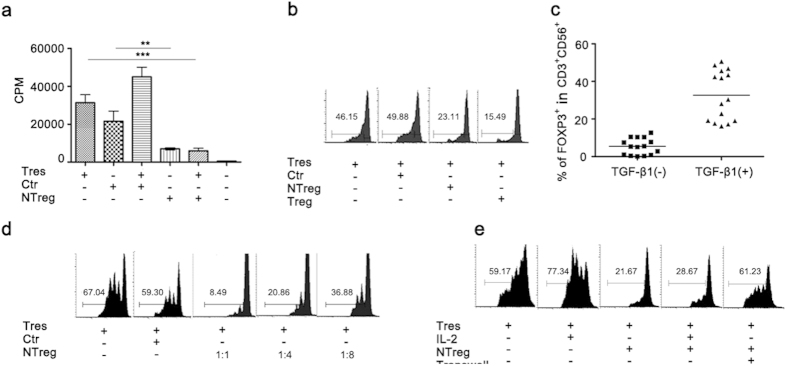
The induction and immunosuppressive function of FOXP3-expressing CD3+CD56+ cells in vitro.(a) In vitro expanded CD3+CD56+ cells were transduced with FOXP3-expressing lentiviral particles pCCL.FP3 or empty particles pCCL. The transduced cells were added at a ratio of 1:2 to cultures of autologous CD4+ T cells (Tres), and tested for inhibitory effect on cell proliferation induced by soluble anti-CD3 (1 μg/ml) in the presence of APCs using 3H thymidine incorporation. Data from three independent experiments are presented as Mean ± SD. Ctr: CD3+CD56+ cells transduced with control pCCL lentiviral particles; NTreg: CD3+CD56+ cells transduced with pCCL.FP3 lentiviral particles. (b) The anti-proliferative effect of FOXP3 transduced CD3+CD56+ cells was compared with that of CD4+CD25high conventional Treg cells by monitoring CFSE dilution of responder cells. Representative results from one out of three independent experiments are presented. The numbers denote the percentages of cells which divided at least once. Ctr: CD3+CD56+ cells transduced with pCCL lentiviral particles; NTreg: CD3+CD56+ cells transduced with pCCL.FP3 lentiviral particles. (c) Induction of Foxp3 expression by TGF-β1. CD3+CD56+ cells isolated from NILs of HCC patients were stimulated with soluble anti-CD3 (1 μg/ml), anti-CD28 (1 μg/ml) and IL-2 (10 ng/ml) in the presence or absence of TGF-β1 (10 ng/ml). FOXP3 expression was detected by intracellular staining at day 4. The horizontal bar denotes the average of FOXP3+ cells in the cultures. (d) The anti-proliferative effect of TGF-β1-induced FOXP3+CD3+CD56+ cells (NTreg) were tested using CFSE dilution assay at a ratio of 1:1, 1:4, or 1:8 with autologous CD4+ T cells treated with anti-CD3. Ctr: uninduced CD3+CD56+ cells; NTreg: TGF-β1-induced CD3+CD56+ cells. (e) The inhibitory effect of TGF-β1-induced CD3+CD56+ cells (NTreg) on anti-CD3 induced proliferation of CD4+ T cells in the presence of exogenous IL-2 or in transwell cultures. The experiments were repeated three times with similar results.